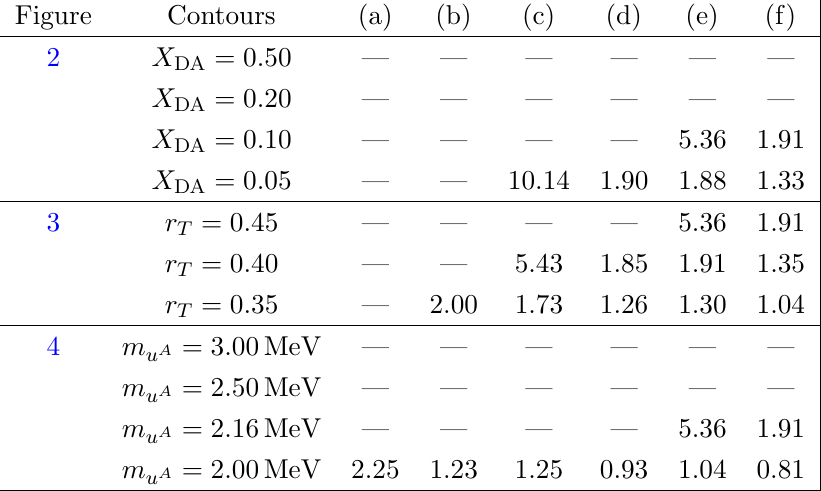
Figure Contours (a) (b) (c) (d) (e) (f) 2 X = 0 : 50 | | | | | DA